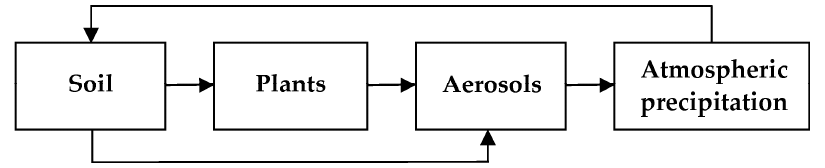
Figure 1. Scheme of phosphorus fluxes in the catchments.